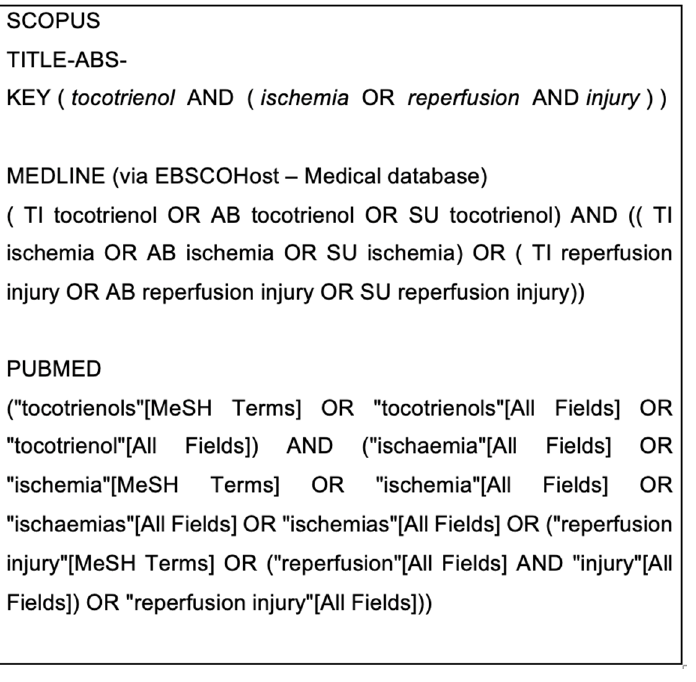
Figure 1. Search strategy.